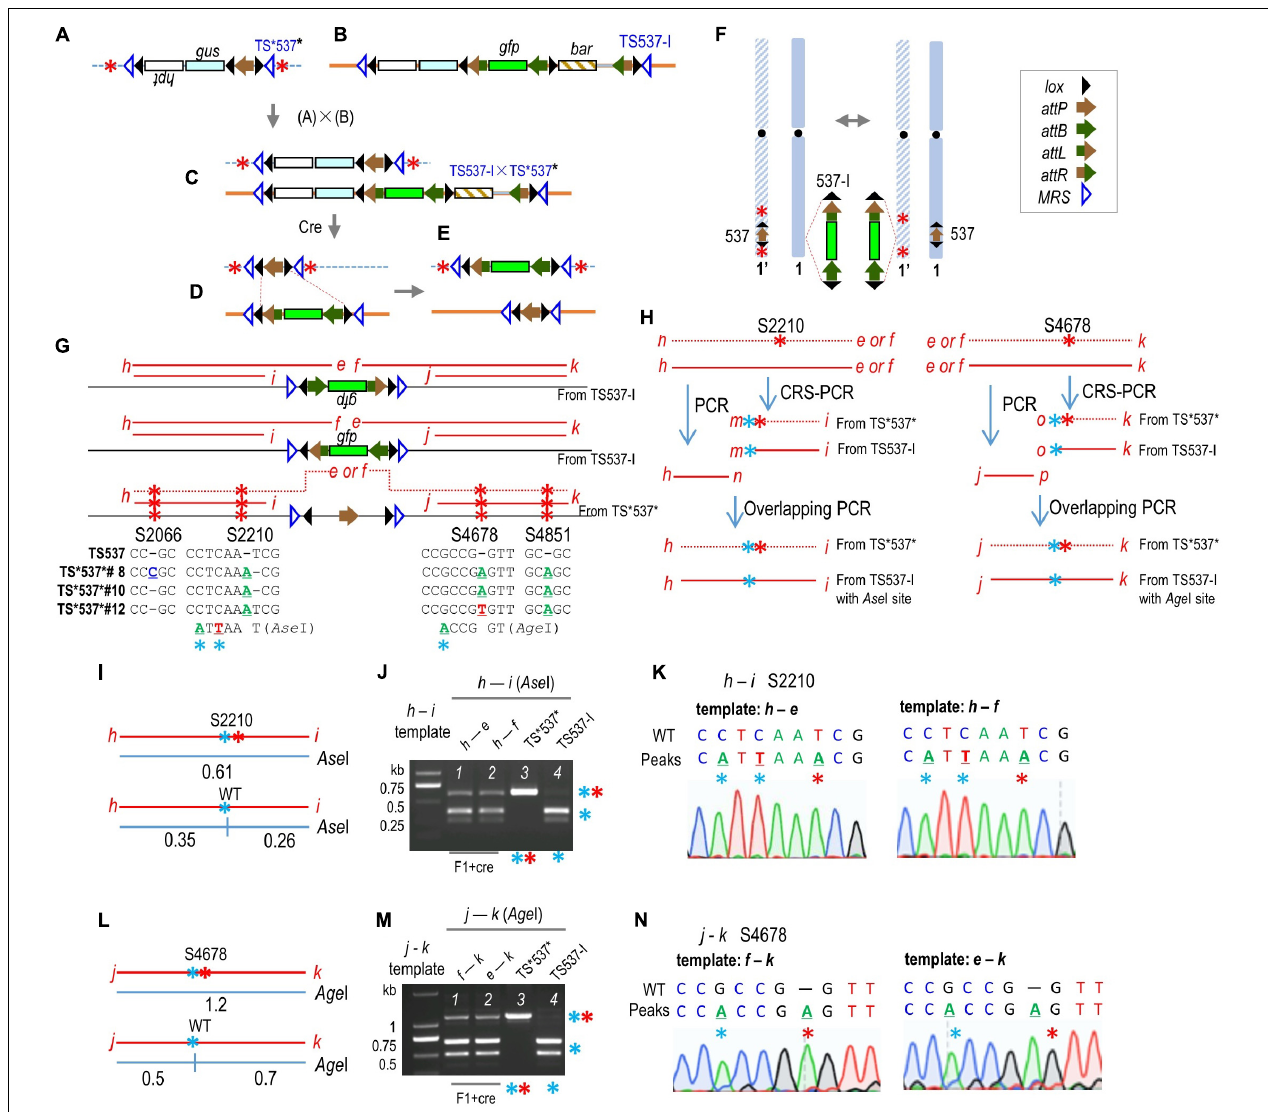
FIGURE 2 | Gene translocation from a target site to an allelic target site. (A) TS*537* structure mutated by CRISPR. (B) Structure of gfp- stacking line TS537-I. (C) Structure of F1 hybrid from TS537-I × TS*537*. (D) Resolved structure from Cre-mediated deletion; inversion not shown. (E) Structure after Cre-mediation reciprocal translocation from recombination between lox sites (red dashed lines) from a TS537-I × TS*537* cross (F) . (G) CRISPR generated mutations in TS*537* (S2066, S2210, S4678, and S4851). Red letters, PCR primers; red lines, PCR products. (H) CRS-PCR and overlapping PCR to create Ase I or Age I restriction site for PCR products derived from TS537, but not from TS*537*. Blue ∗ indicates mutation in PCR primer to form restriction site, red ∗ indicates CRISPR mutations that abolish restriction site. Expected fragment sizes (in kb) and data from Ase I (I,J) or Age I (L,M) cleavage of CRS-PCR/overlapping PCR products of F1 + cre DNA. Sequencing results of h–i fragment resistant to Ase I (K) or Age I (N)